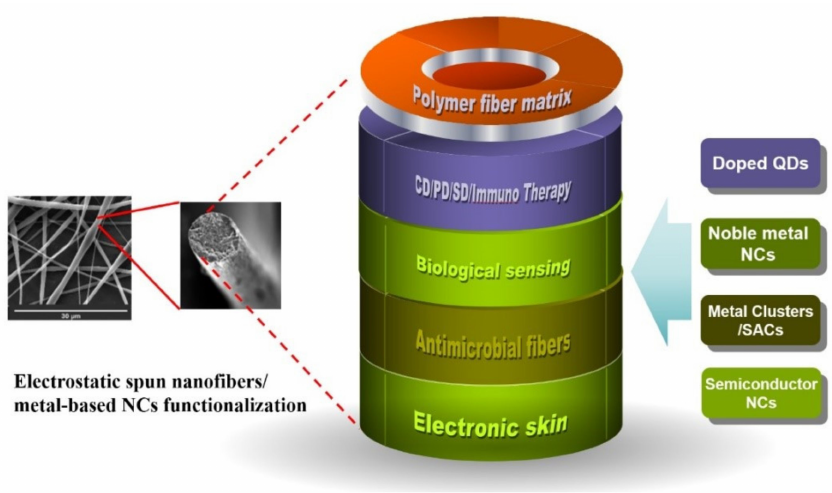
Figure 11. The outlook of metal-based NC functionalization in electrostatic spun nanofibers for extended